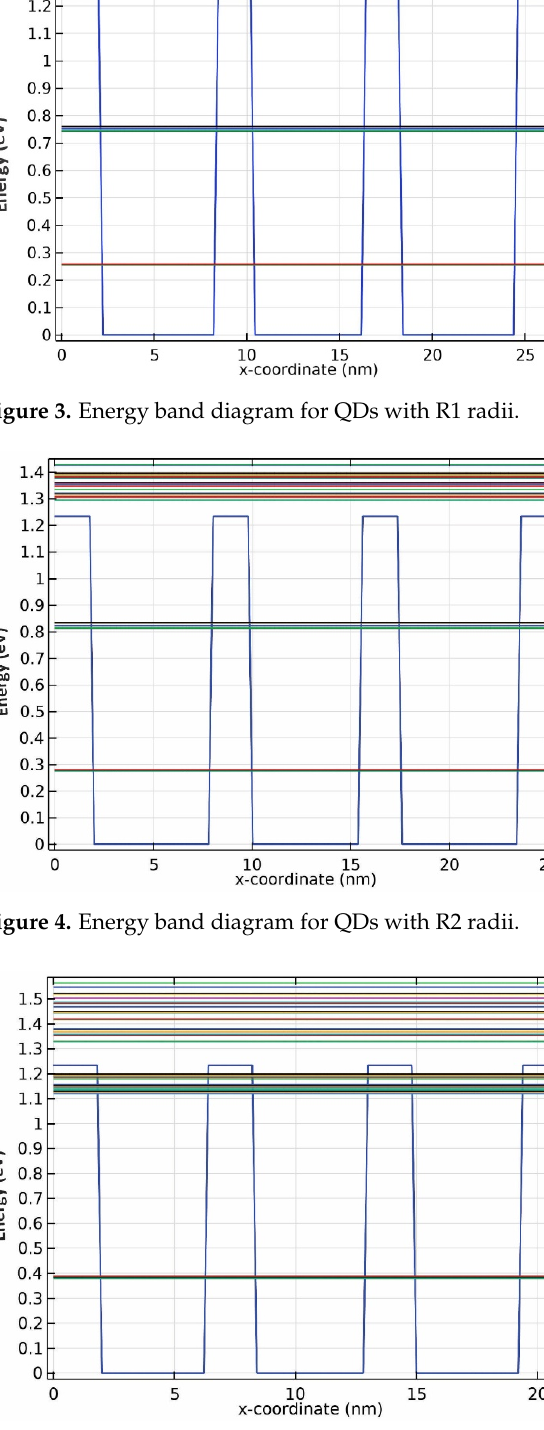
Figure 5. Energy band diagram for QDs with R3 radii.